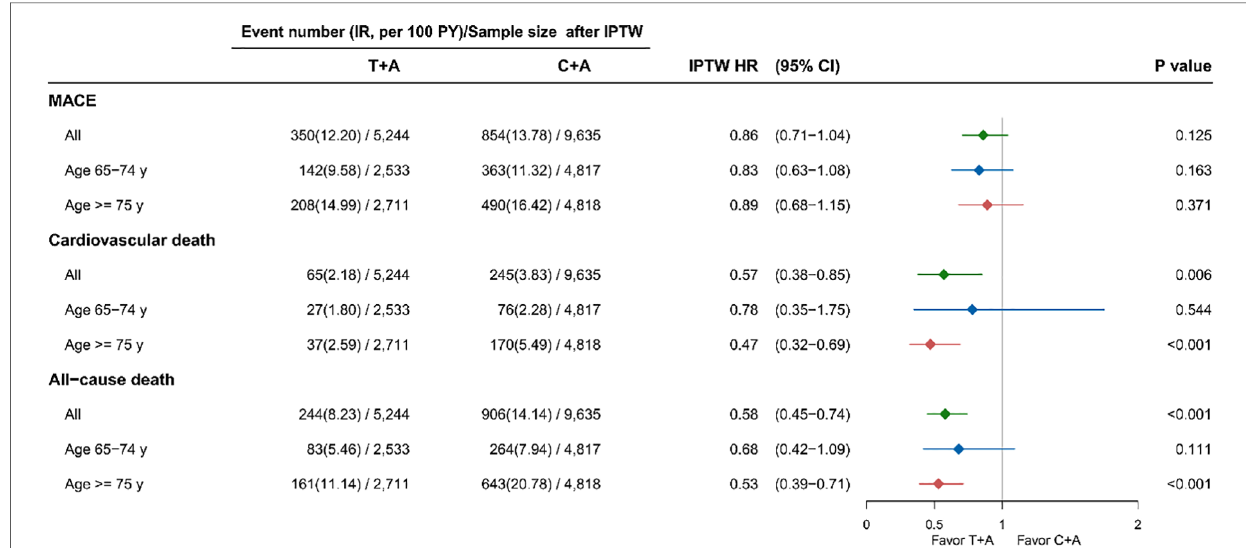
FIGURE 2 Effectiveness of ticagrelor and clopidogrel on MACE, cardiovascular death and all-cause death among AMI patients. A, aspirin; AMI, acute myocardial infraction; C, clopidogrel; HR, hazard ratio; IPTW, inverse probability treatment weighting; MACE, major adverse cardiovascular events; T, ticagrelor; y, years.